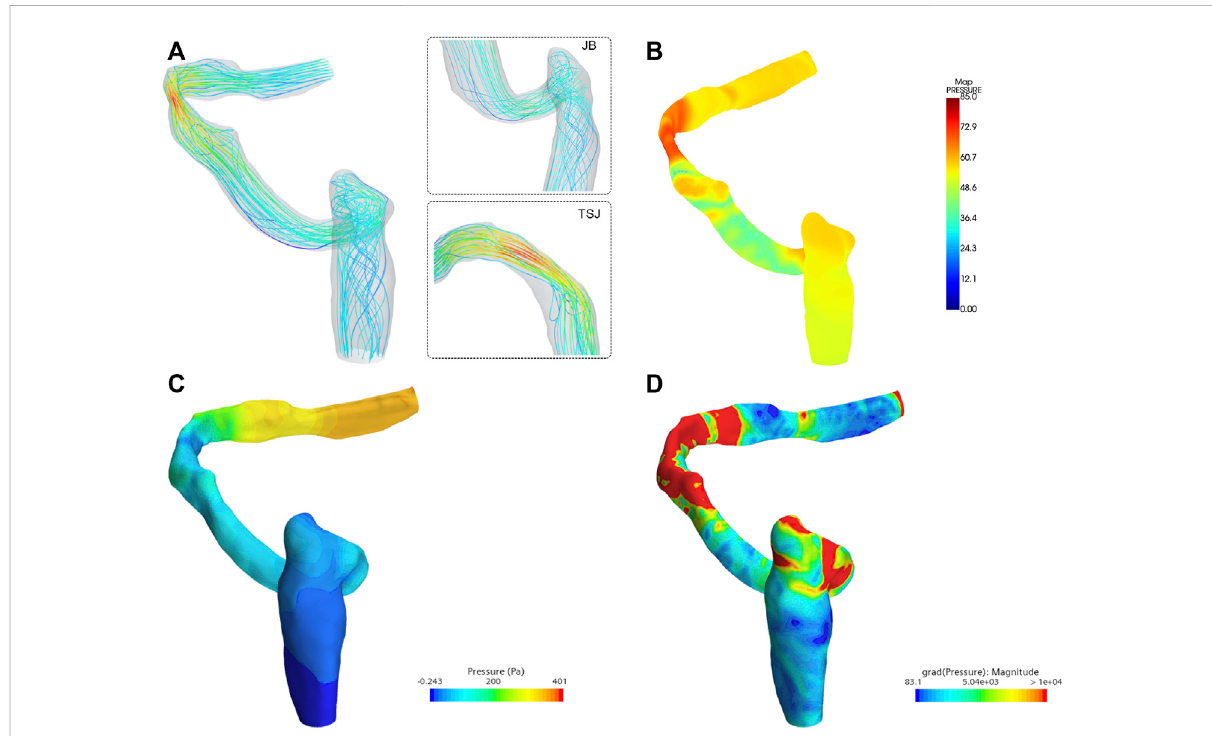
FIGURE 6 Hemodynamic characteristics of the fl ow fi eld. TSJ indicates transverse-sigmoid sinus. JB indicates jugular bulb. (A) Flow velocity and streamline, (B) visualization of the acoustic fi eld (unit: dB), (C) wall pressure distribution, and (D) pressure gradient inside the ipsilateral transverse- sigmoid sinus (unit: